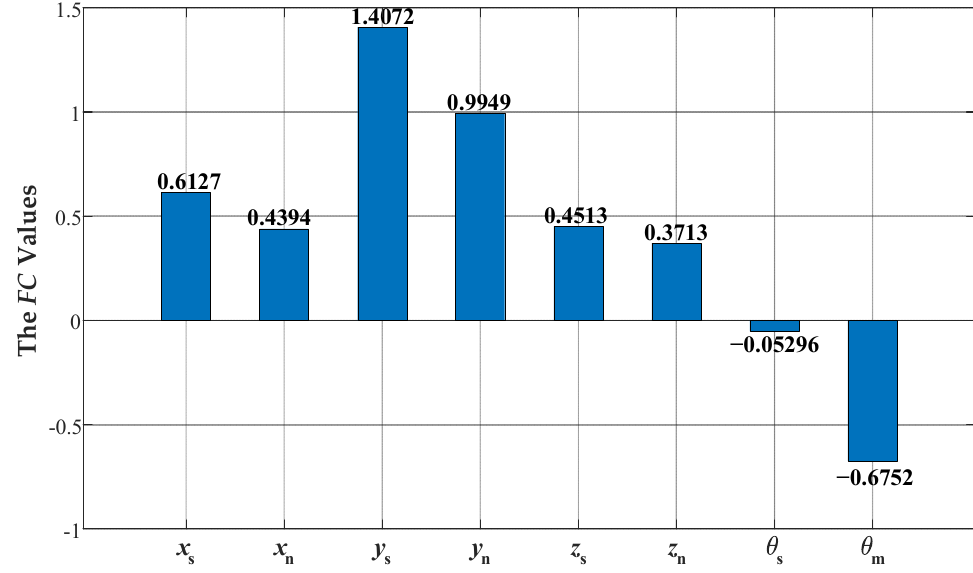
Figure 14. Simulated FC values of all eight parameters.